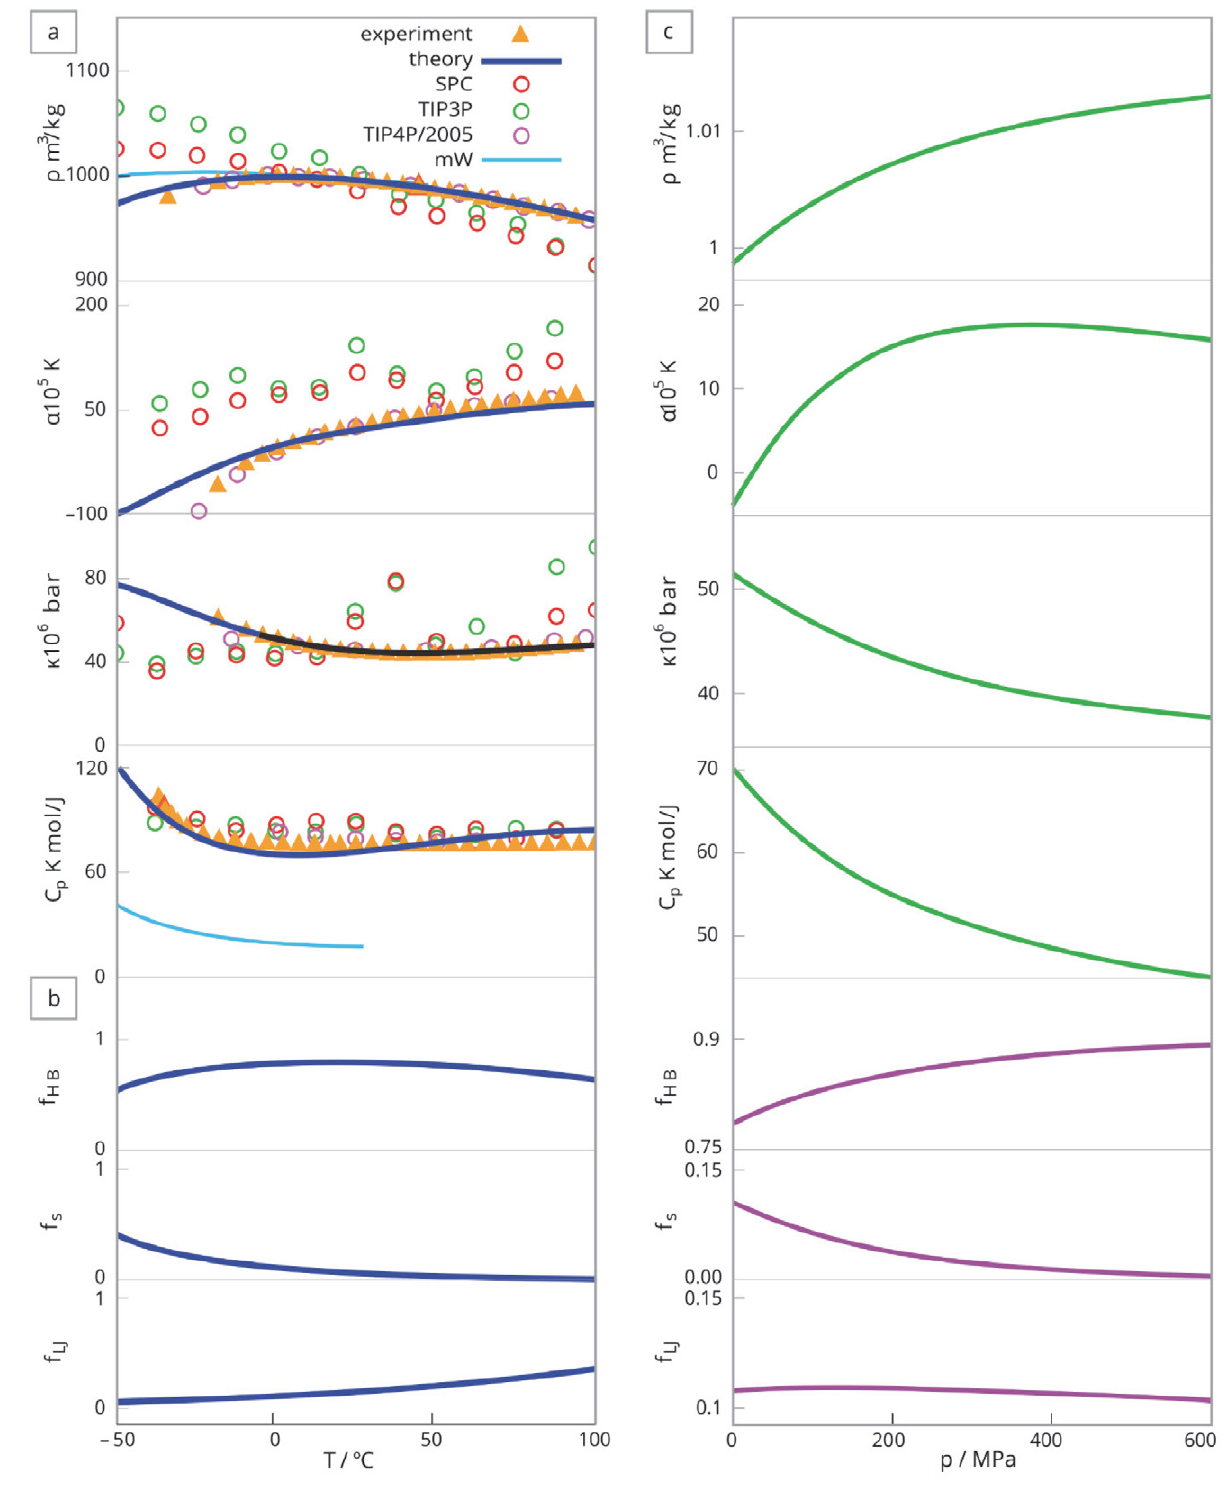
Figure 14: Experimental liquid water properties (yellow full triangles) vs model predictions (dark blue solid line) and computer simulations. (a) Temperature dependence of liquid water’s density, thermal expansion coefficient, isothermal compressibility, and heat capacity at 1 bar pressure. Experiments are from Eisenberg and Kauzmann. 8 Computer simulations are from Abascal and Vega for TIP4P/2005 21 and Jorgensen and Jenson for TIP3P 20 and SPC 20 , and mW model predictions from Molinero and Moore 56 . (b) Molecular constituents of water at different temperatures: HB (hydrogen-bonded waters), s (12-mer hexagons), and LJ (waters in contact but not hydrogen bonded). (c) Pressure dependences of the same prop- erties and their constituents at a temperature of 273